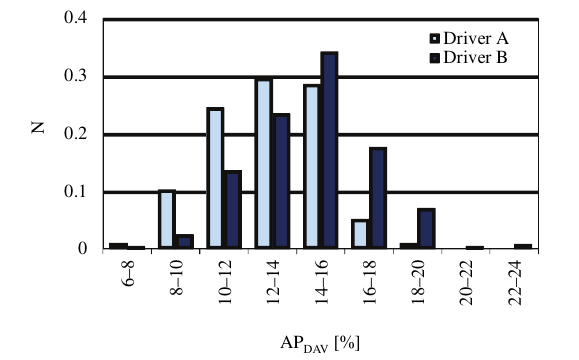
Fig. 24. Average relative position of accelerator pedal, excluding vehicle stops, in urban driving conditions